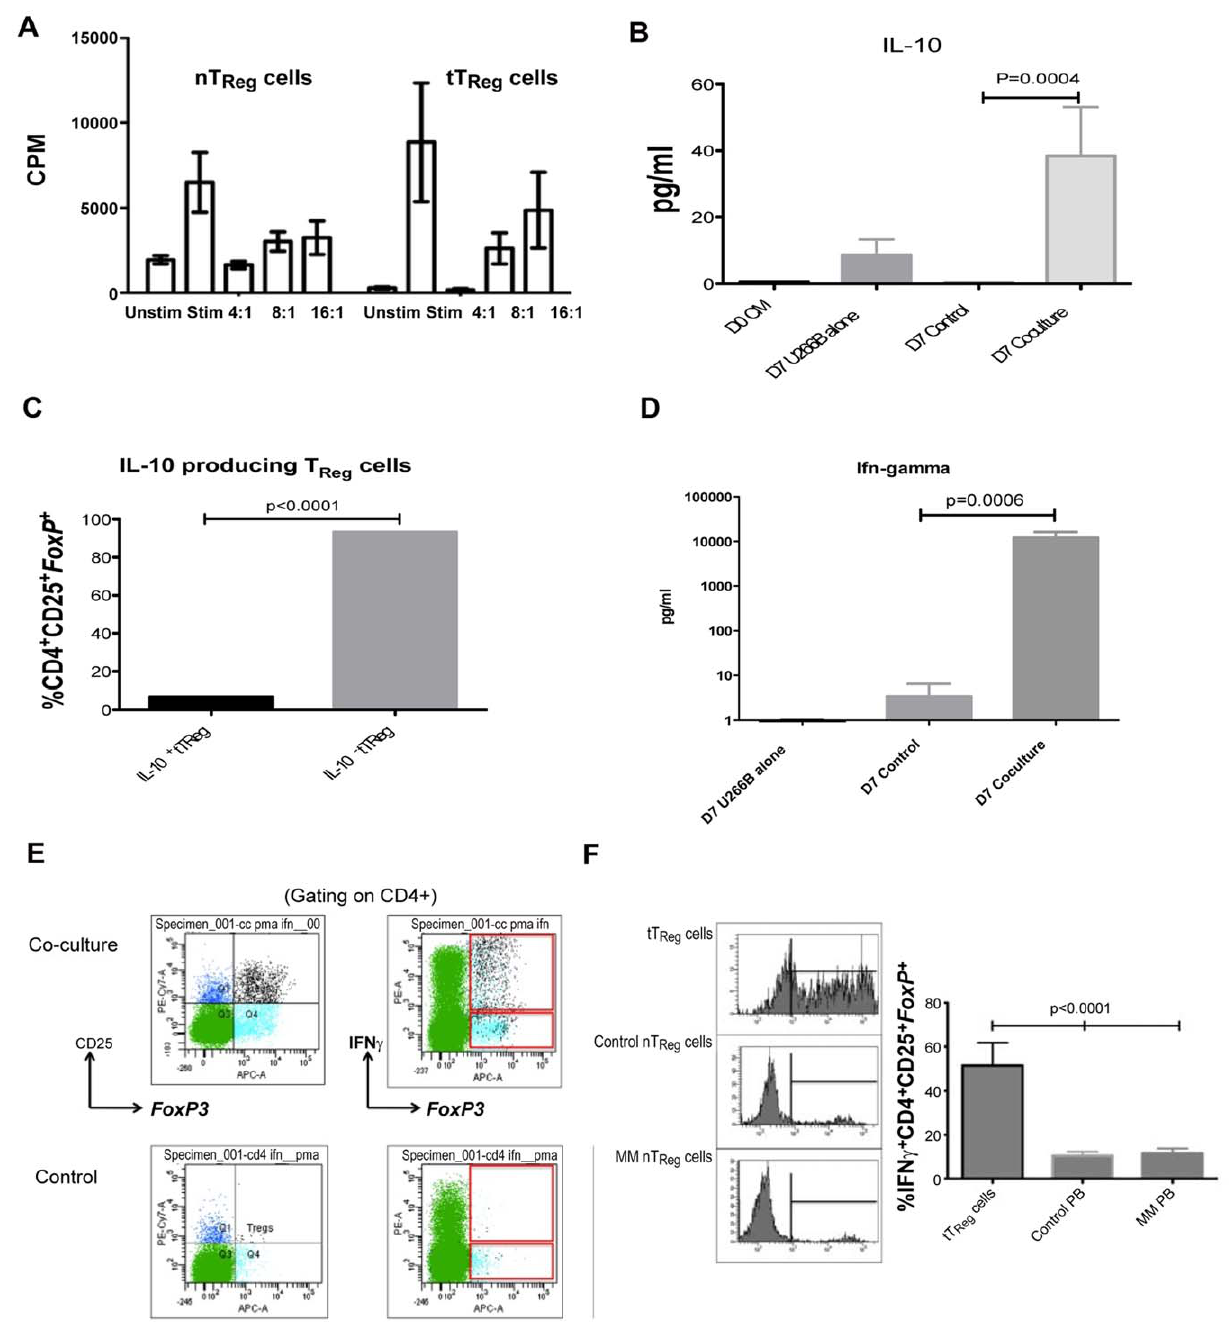
Figure 3. Functional characteristics of tumour-induced regulatory T-cells. A. Suppression of anti-CD3/anti-CD28-induced autologous T-cell proliferation by tumour-generated and naturally occurring T Reg cells (n=3), as determined by tritiated thymine incorporation. Results expressed as counts per minute (cpm) 6 SEM representing assays performed in triplicate. Key: Unstim – resting CD4 + CD25 - T cells, Stim – CD3/CD28 stimulated CD4 + CD25 - T-cells, 4:1 etc – ratio of stimulated autologous T-cells to T Reg cells. B. The generation of IL-10 in co-cultures of CD25 - CD4 + sorted T-cells and HMCL, compared with HMCl alone and culture medium (n=6, p=0.0004). Results represent all experiments, expressed as mean 6 SEM and analyzed using student t-test. C. IL-10 production by tT Reg cells after 7 days of co-cultures of CD25 - CD4 + sorted T-cells and HMCL. Results represent all experiments, expressed as mean 6 SEM (n=3) and analyzed using student t-test. D. IL-10 production by tT Reg cells after 7 days of co-cultures of CD25 - CD4 + sorted T-cells and HMCL. Results represent all experiments, expressed as mean 6 SEM (n=3) and analyzed using student t-test. E. Representative flow cytometry plots demonstrating the generation of IFN c + FoxP3 + CD25 + CD4 + T-cells from CD4 + CD25 - T-cells in a 7 day co-culture assay with mitomycin C-treated U266B cells. F. The proportion of IFN c -producing FoxP3 + CD25 + CD4 + T-cells detectable in the peripheral blood of age- matched controls (n=15), patients with MM (n=15) and tTReg cells generated in vitro after 7 days of co-cultures of CD25 - CD4 + sorted T-cells and HMCL (n=3). Histograms represent IFN c production by cells gated on FoxP3 /CD25/CD4 positive staing. Results expressed as mean 6 SEM.